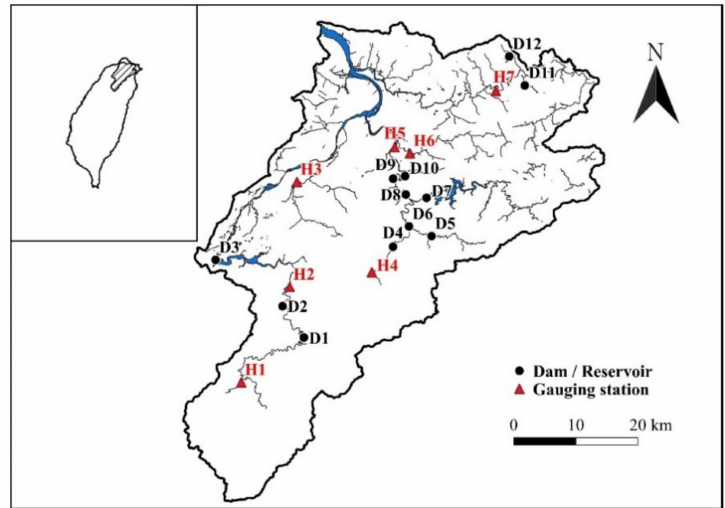
Figure 1. Spatial locations of selected seven streamflow gauge stations (H1 to H7) and 12 dams (D1 to D12) in the Tamsui River basin, Taiwan.